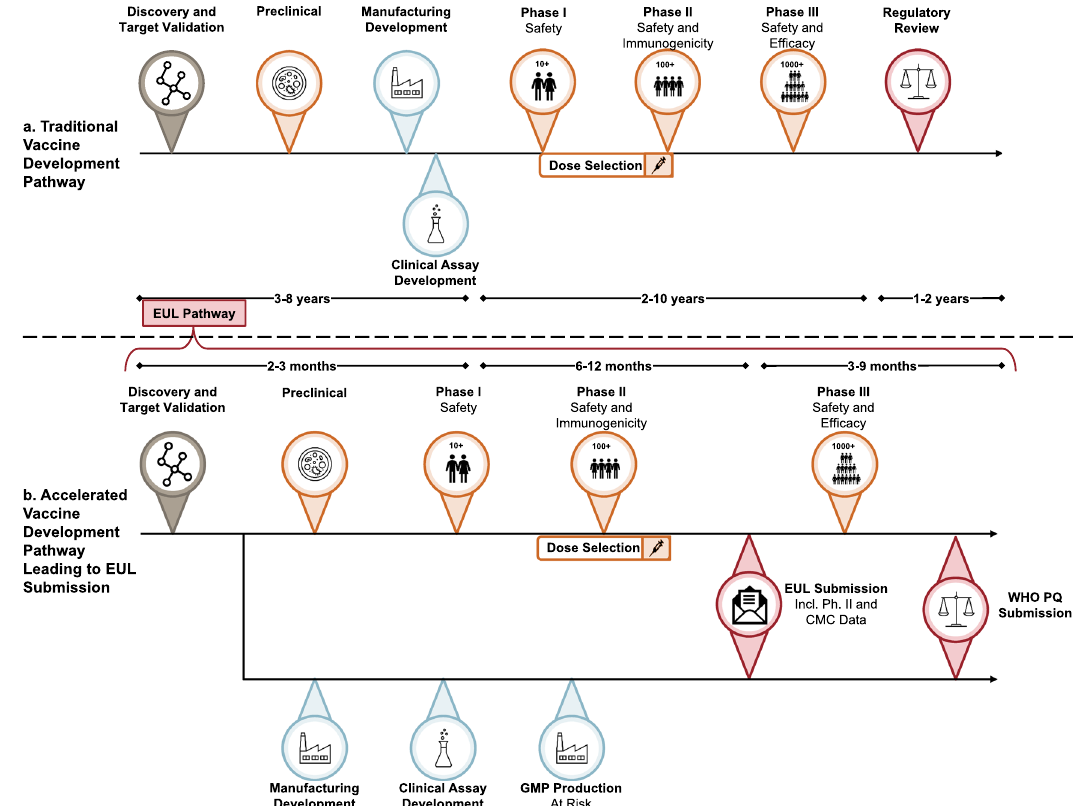
Fig. 1 Potential for acceleration across all aspects of development for an EUL submission. Comparison of the traditional drug and vaccine development timeline adapted from Heaton 4 ( a ) with an idealized vaccine development timeline targeting World Health Organization Emergency Use Listing submission based on nOPV2 and COVID-19 experiences ( b ). Symbols are used to indicate key stages in the vaccine development process; orange-red shading for clinical and blue shading for CMC